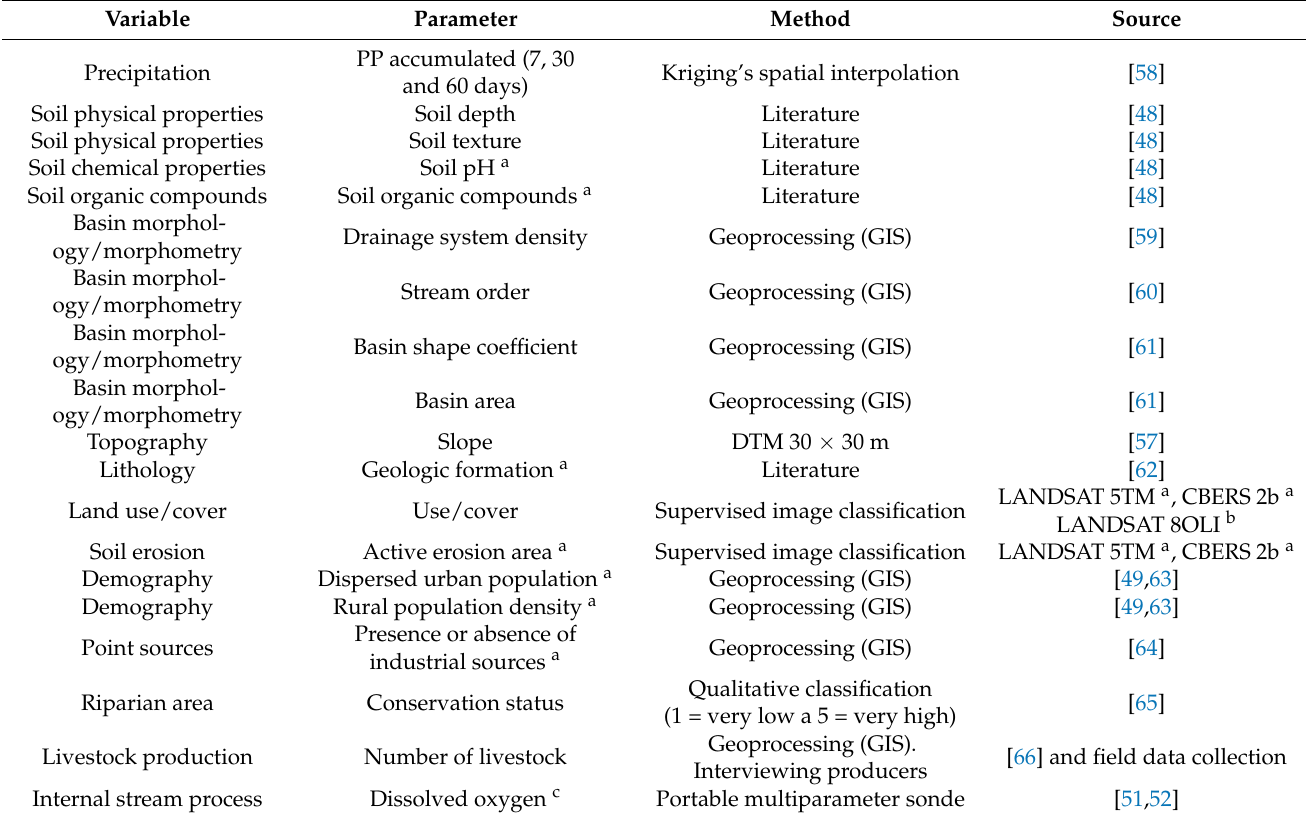
Table 1. Variables, parameters, method and spatial database source used for